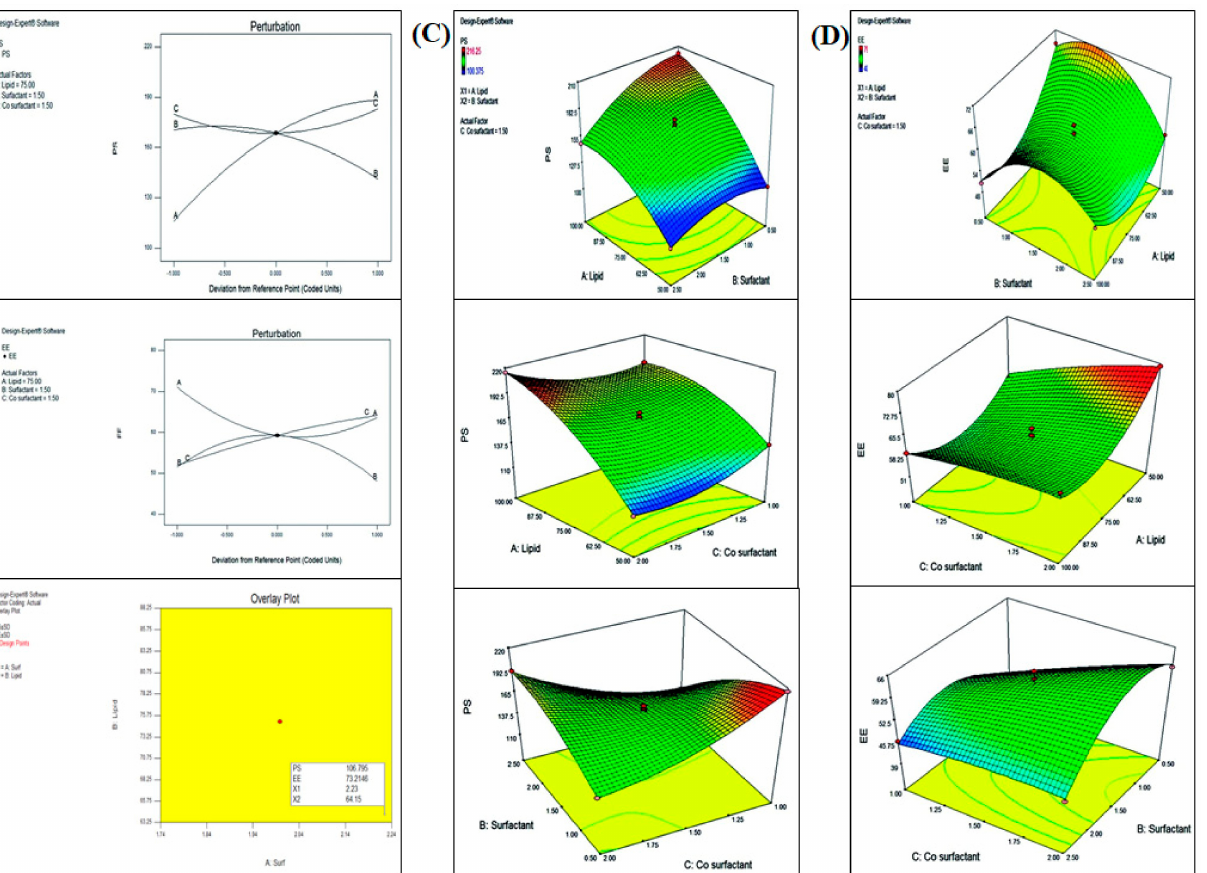
64.15 mg of palmitic acid lipid and 2.23% surfactant along with 0.4% soy lecithin were nm) with a %EE of 72.67 ± 4.61% (predicted data 73.21%). The observed findings are in close accord with the design’s BBD-model projected